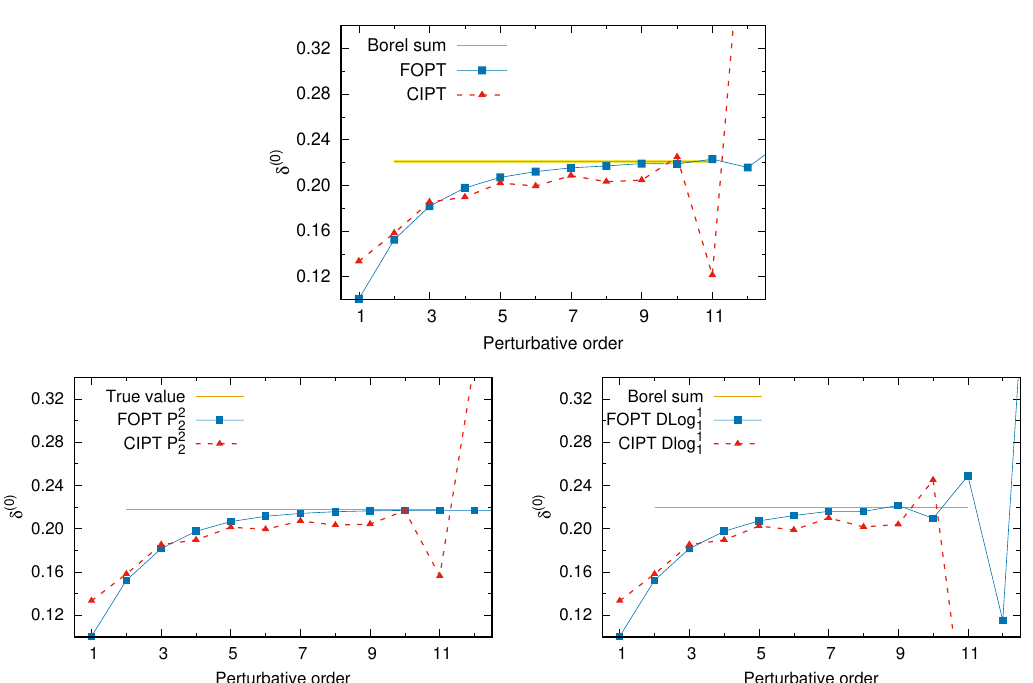
Figure 1: Perturbative expansion of δ ( 0 ) in FOPT and CIPT. (Upper panel) exact large- β limit, (lower-left panel) results from P 2 0 ( u ) . See text for the details regarding the approximants. (The figures in the Dlog 1 1 lower panels are extracted from Ref. [ 21 ] .) Table 1: QCD Adler function coefficients from PAs to the α